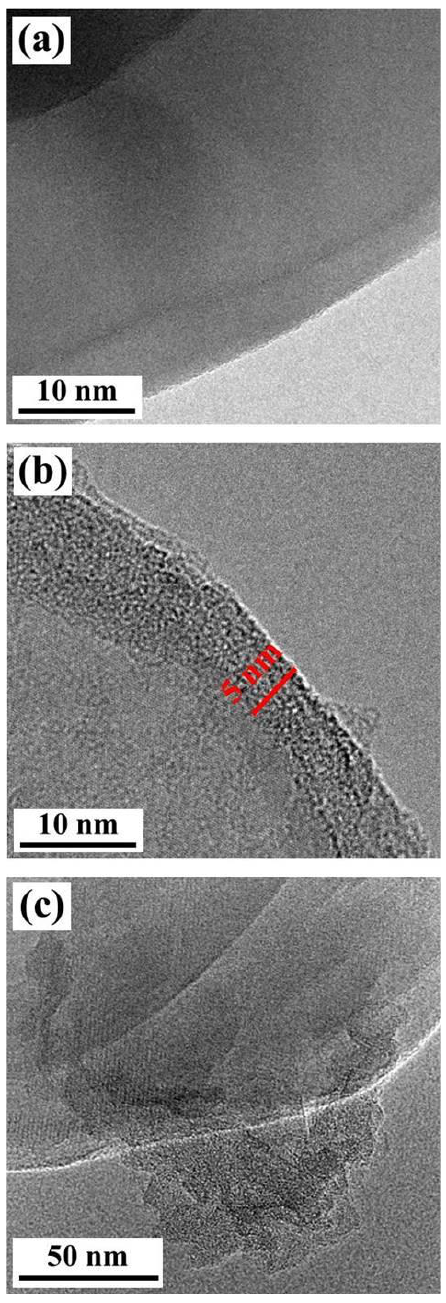
Figure 4. HR-TEM images of ( a ) hBN, ( b ) mhBN, and ( c )